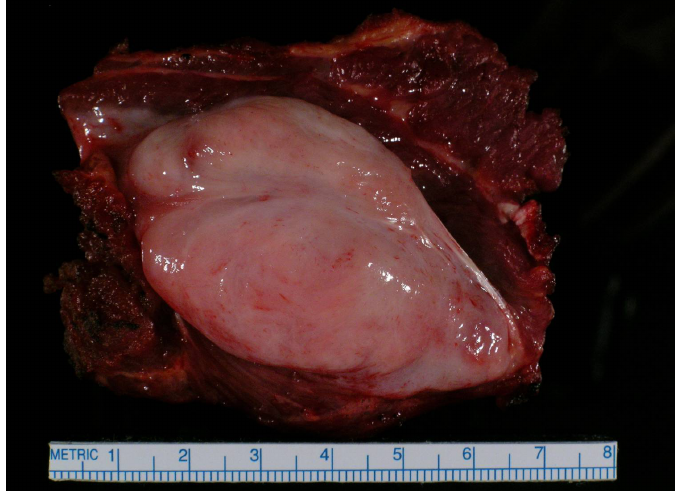
Figure 4. Gross specimen on cut section. These tumors occur as gray-white, firm, poorly demarcated masses. They are rubbery and tough, and infiltrate surrounding